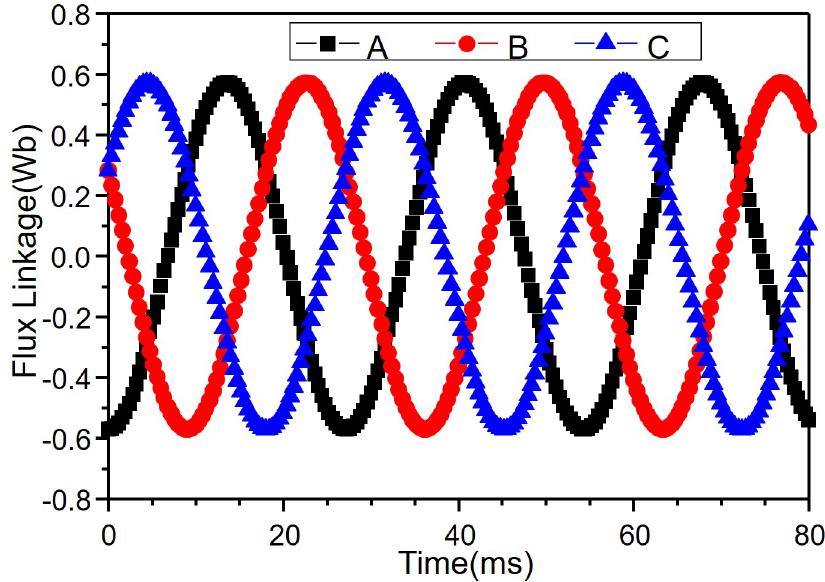
Figure 17. Waveform of three-phase flux linkage under no-load.